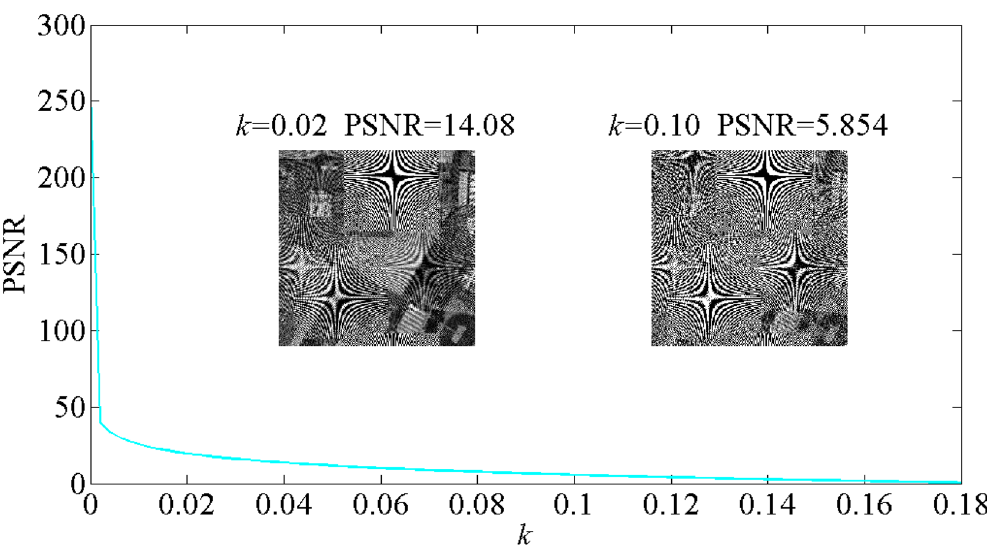
Figure 10. The experimental result of noise attack including the decrypted image achieved with k = 0.02 and k =